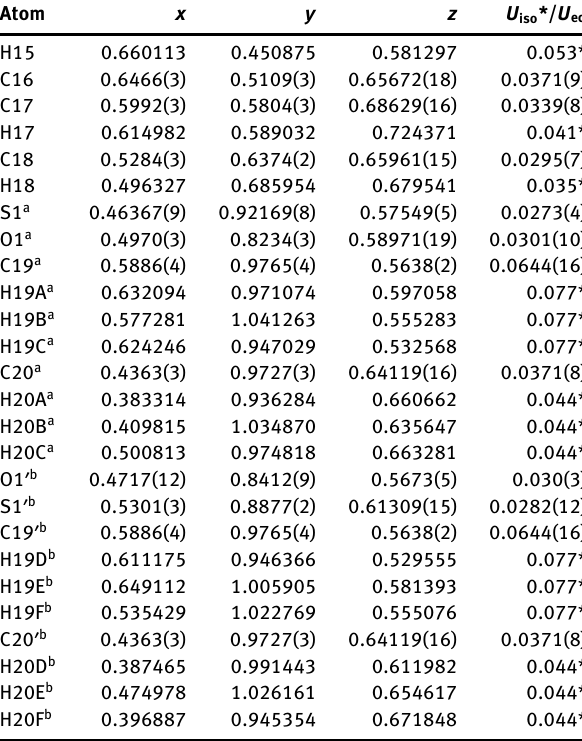
metry operations (i) 1/2 + x , 3/2 − y , 1 − z , (ii) 1 − x , 2 − y , 1 − z and (iii) − 1/2 + x , 3/2 − y , 1 − z ] assemble molecules into a supramolecular layer in the ab -plane. The points of contact between layers include weak Cl· · · Cl,